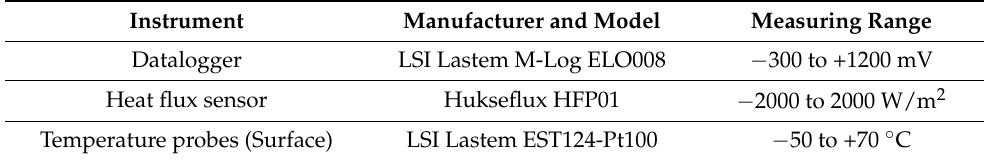
Table 2. Technical descriptions of the measuring instrument.